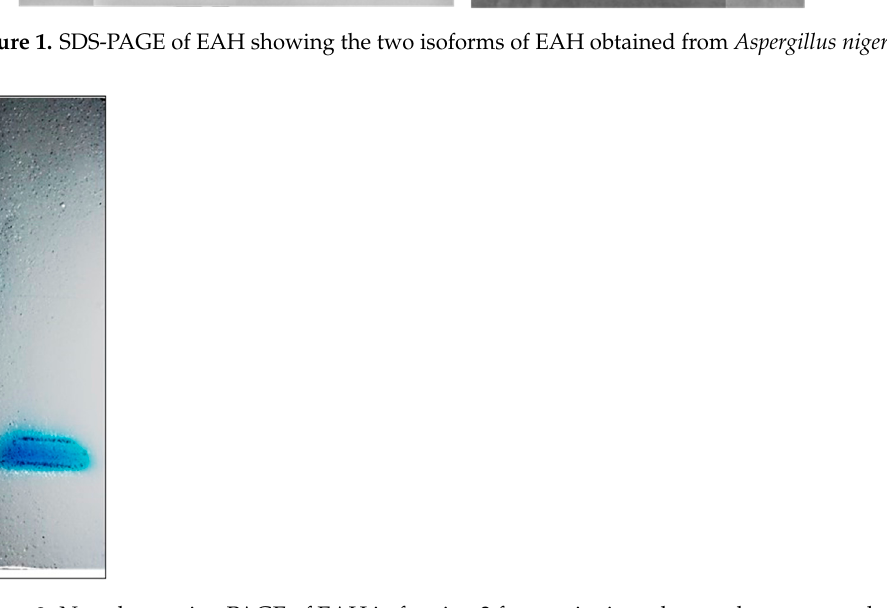
Figure 2. Non-denaturing PAGE of EAH in fraction 3 from anionic exchange chromatography.